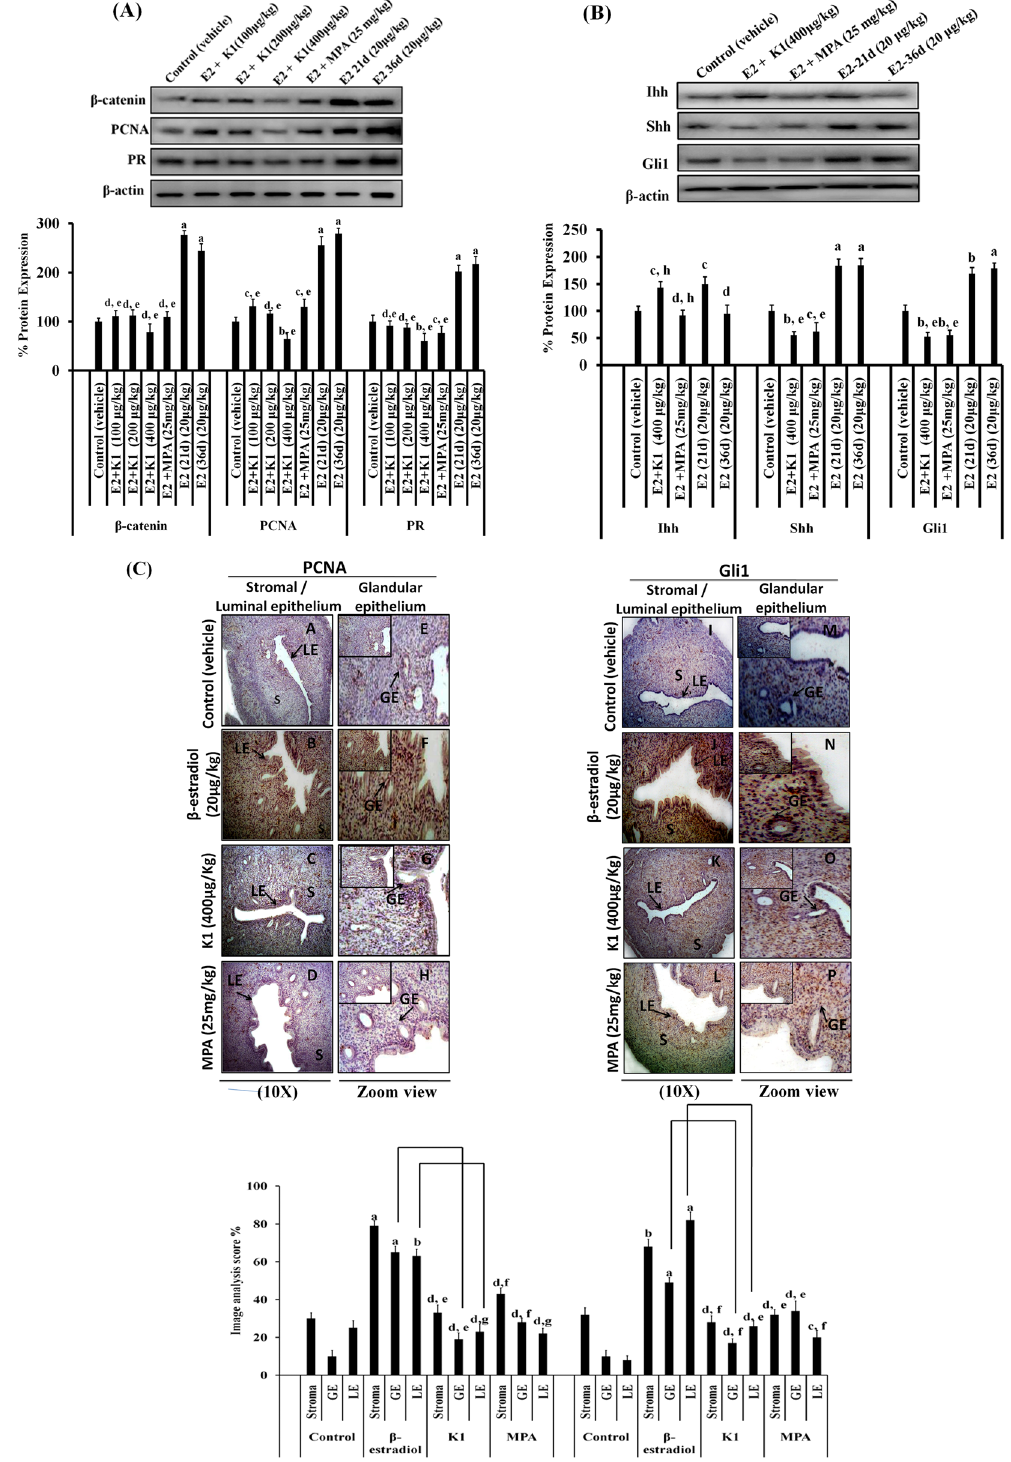
Figure 7. Anti-estrogenic agent (K1) or progestin (MPA) treatment antagonized estrogen- induced activation of Hh signaling molecules in rat uterine tissue. ( A ) Representative western blot images showing the expression of proliferative markers such as PR, PCNA and β - catenin in uterine tissue of rats treated with β - estradiol (E2), K1 or MPA. β -actin was used as internal loading control. Densitometric data shown as % change in protein expression levels. Results are expressed as mean ± SEM, n = 3 (independent samples). p values: a p < 0.001, b p < 0.01, c p < 0.05 and d p > 0.05 vs. control; e p < 0.001, f p < 0.01, g p < 0.05 and h p > 0.05 vs. E2 (36d) administered groups. ( B ) Representative western blots illustrating the expression of Ihh, Shh and Gli1 in rat uterine tissue. Densitometric data shown as % change in protein expression levels. Values are expressed as mean ± SEM, n = 3 (independent samples). p values are: a p < 0.001, b p < 0.01, c p < 0.05 and d p > 0.05